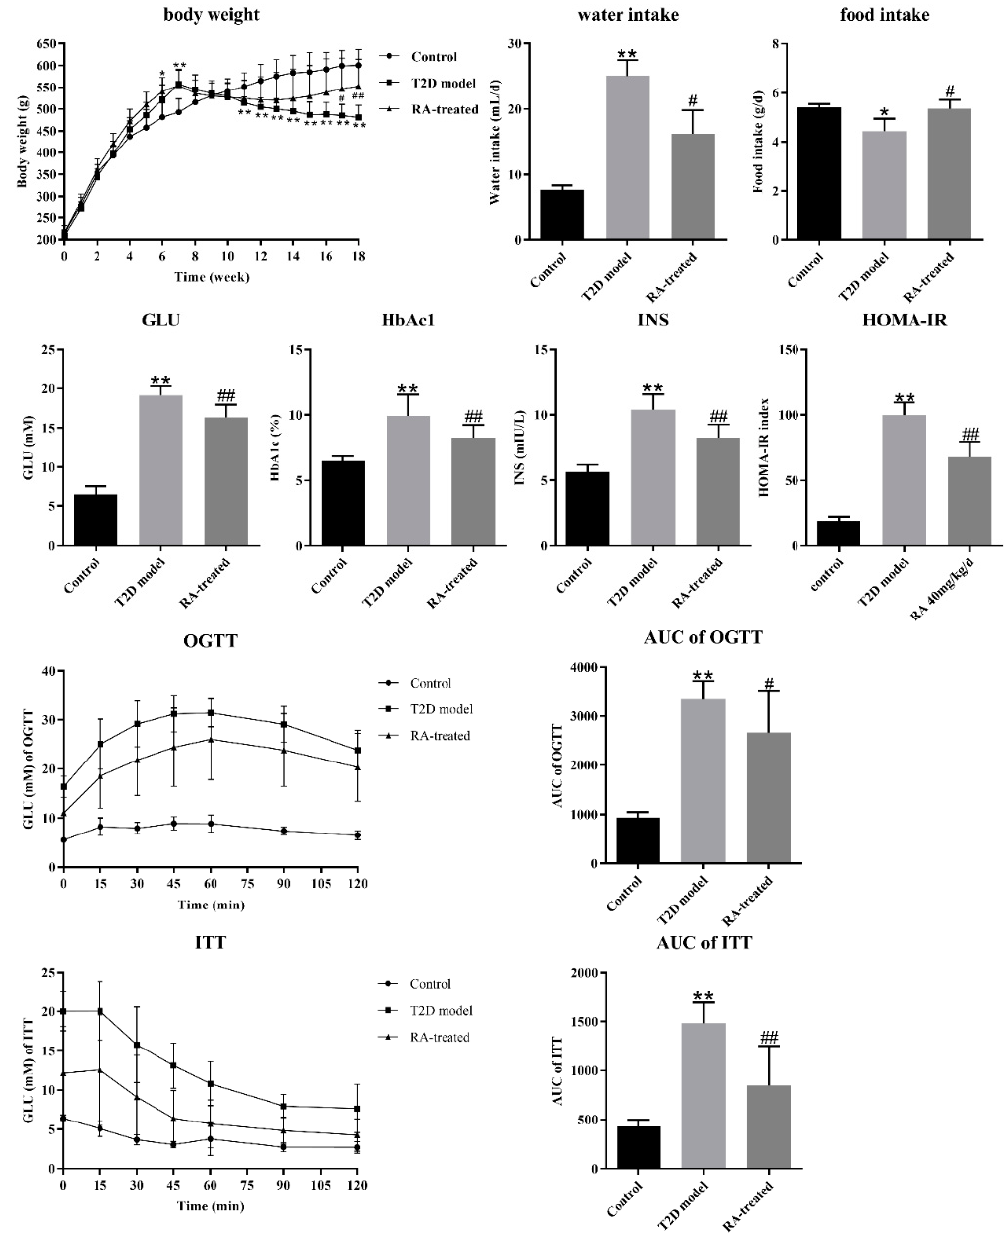
Figure 1. E ff ects of rotundic acid (RA) on body weight, water intake, food intake and glucose metabolism (glucose (GLU), HbAc1, insulin (INS), the HOMA-IR index, the oral glucose tolerance test (OGTT), the area under the curve (AUC) of the OGTT, the insulin tolerance test (ITT) and the AUC of the ITT). Data were presented as the mean ± SD ( n = 8 per group). * p < 0.05 vs. control group; ** p < 0.01 vs. control group; # p < 0.05 vs. T2D model group; ## p < 0.01 vs. T2D model group by Tukey’s multiple comparison